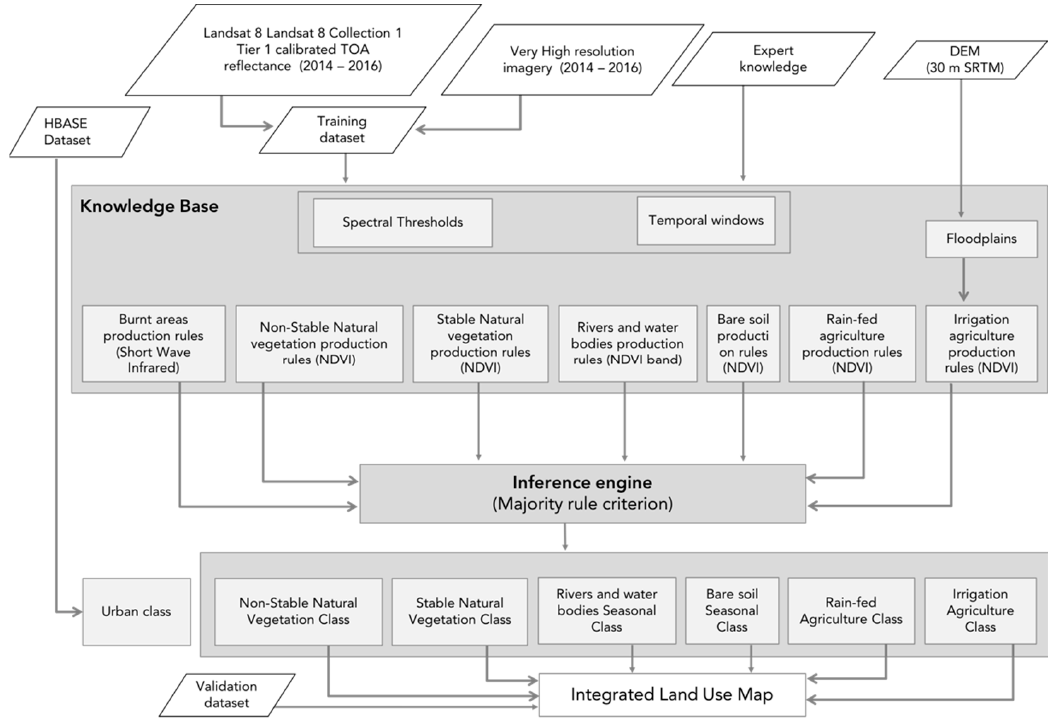
Figure 3. Flow chart of mapping framework for land cover land use map based on dense stacks of Landsat 8 imagery.